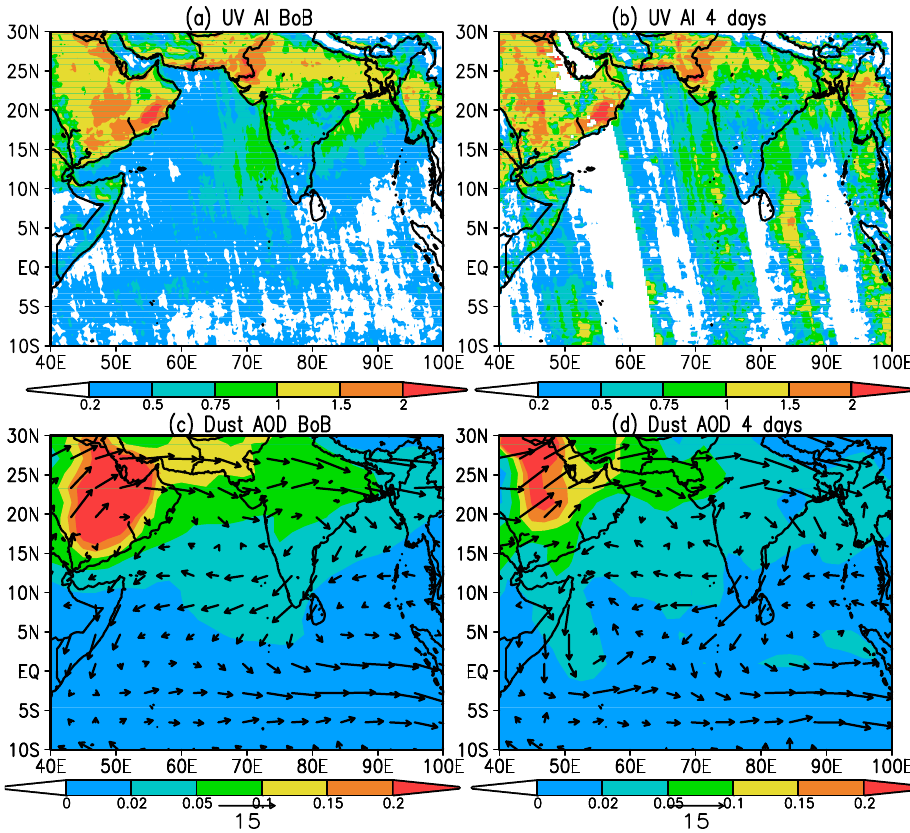
Fig. 5. Comparison of modelled dust AOD at 550nm to Aura-OMI satellite derived UV Aerosol Index (AI) for the entire BoB periods (18 March–11 April; a and c ) and for the average of 4 days when dust from source regions was missing in ECHAM5.5-HAM (18 March, 19 March, 28 March, and 2 April, b and d